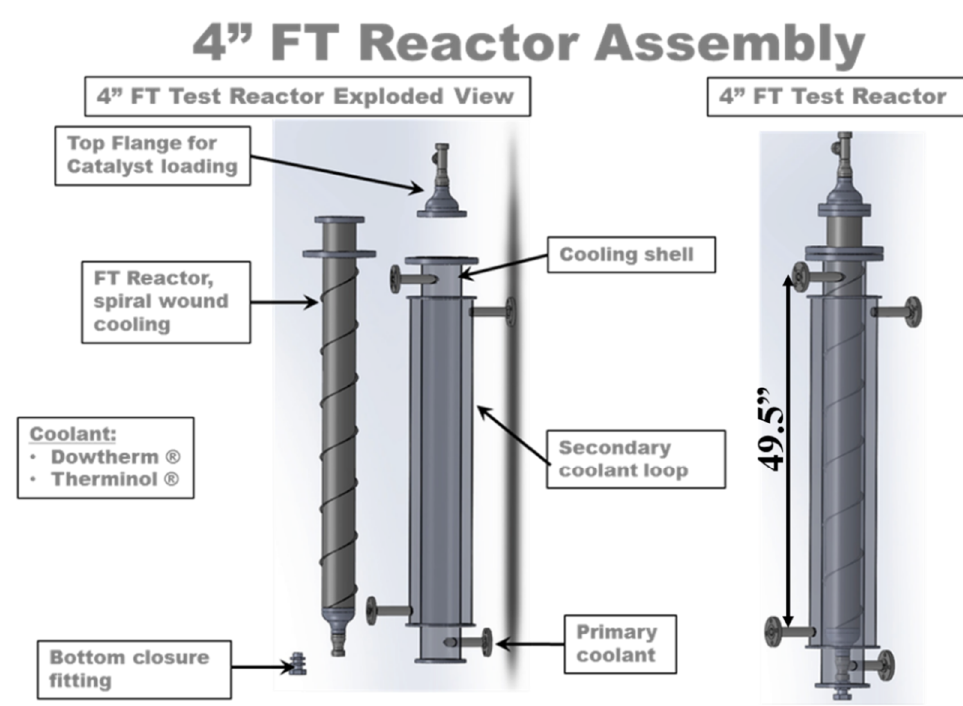
Figure 1. Schematic of OxEon Energy commercial-scale fixed-bed reactor prototype and dimensions.